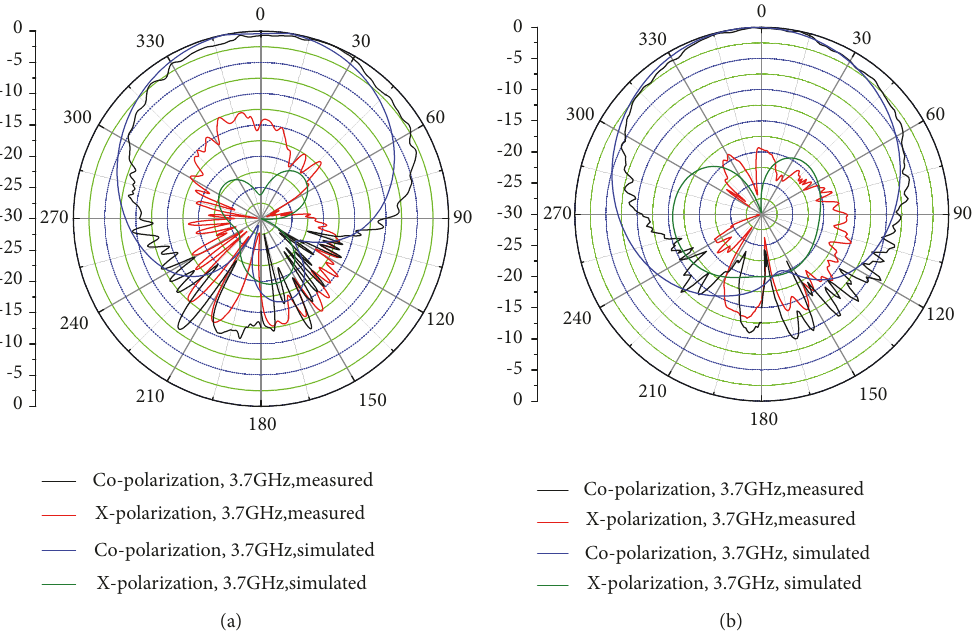
Figure 13: Measured and simulated radiation patterns of mode A: (a) E plane; (b) H plane.